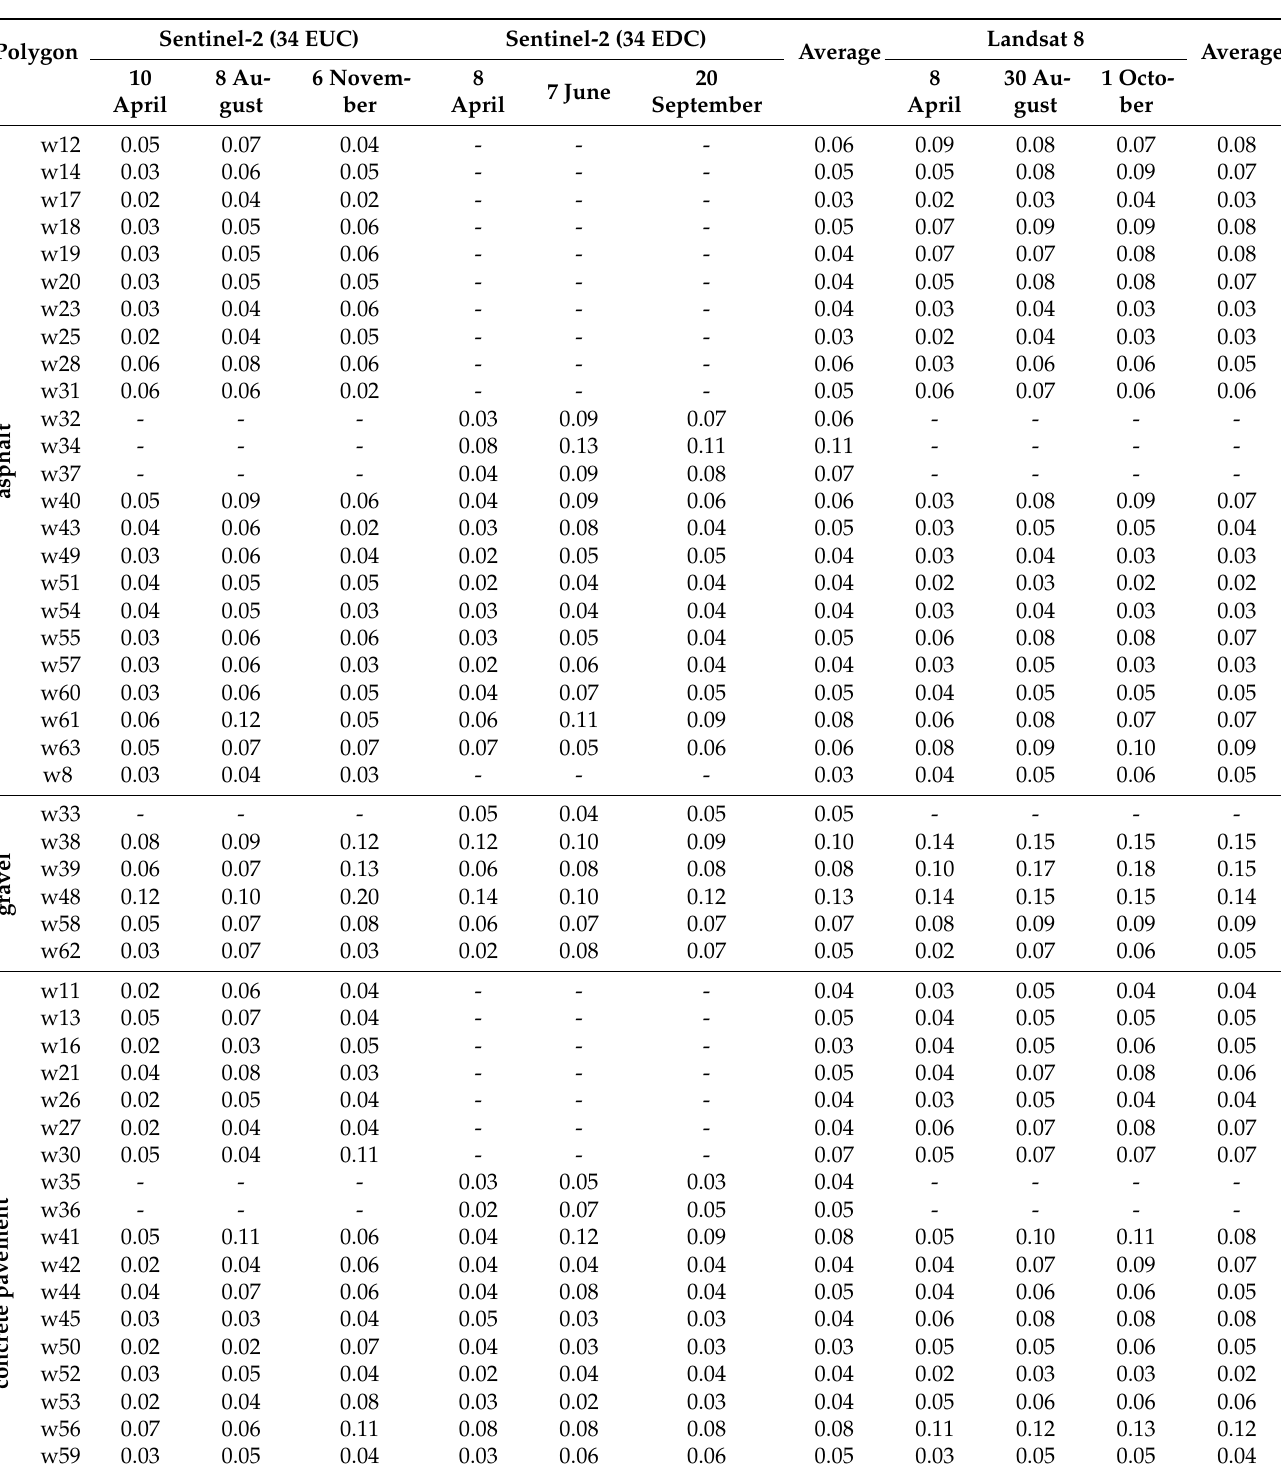
Table A1. Root mean square errors (RMSE) between ground calibration targets and atmospherically verified used Sentinel-2 and Landsat images (Warsaw research